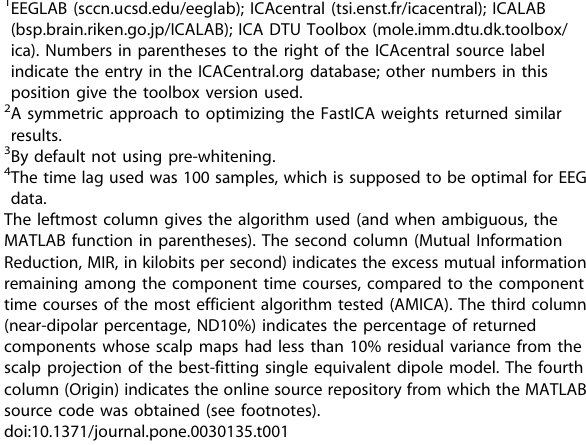
Figure 1. Component dipolarity and equivalent dipole density. A . Example component scalp maps more (top) to less (bottom) resembling the projection of a single equivalent dipole. Eight interpolated independent component (IC) scalp maps with progres- sively more difference from the projection of the best-fitting equivalent dipole (ED) (percent of residual variance (r.v.) indicated for each map). All but the bottom-right component scalp map are from AMICA decompositions. 1 st row: (left) frontal midline IC with prominent theta band activity; (right) right parietal IC with a more tangentially oriented ED model and prominent alpha band peak. 2 nd row: (left) central parietal IC likely reflecting coupled field activity in adjacent left and right medial cortex; (right) more anterior midline IC. 3 rd row: (left) IC accounting for EMG activity of a right post-auricular muscle; (right) IC of uncertain origin. 4 th row: (left) IC accounting for electrode noise at the most affected (red) scalp electrode; (right) high-order PCA component with a characteristic ‘checkerboard’ scalp map unlike the projection of any single ED. B . Mean (left) medial sagittal and (right) axial (z=40 mm) densities of near-dipolar (r.v. , =5%) component equivalent dipoles across all data sets, from four (indicated) decomposition methods.